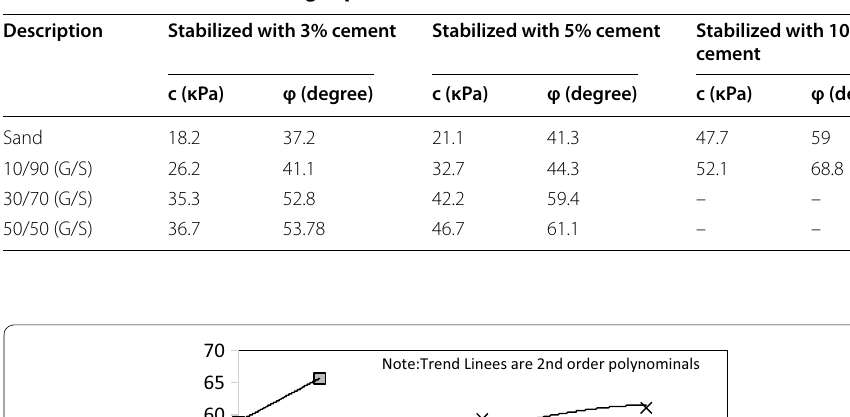
Table 3 Direct shear test strength parameters of stabilized SP and CG–SP blends